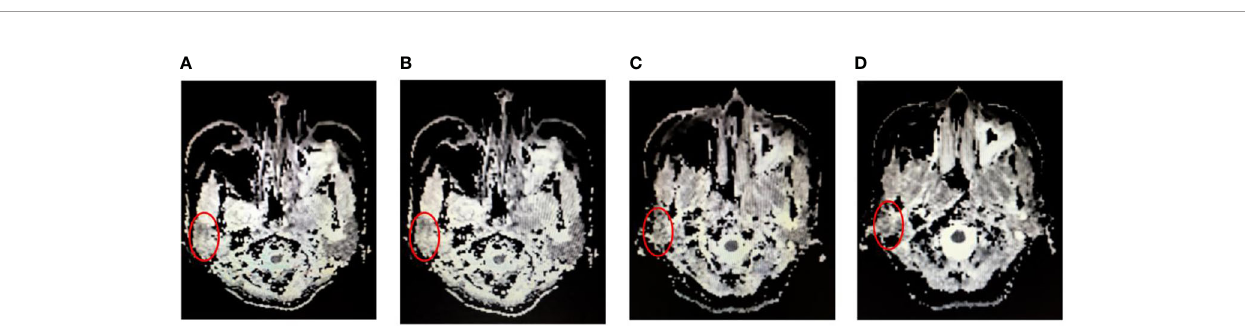
FIGURE 2 | Typical DWI image for parotid glands (red circles) during radiotherapy. (A) at pre-radiation, (B) at 15 th radiation, (C) at 25 th radiation and (D) at completion of